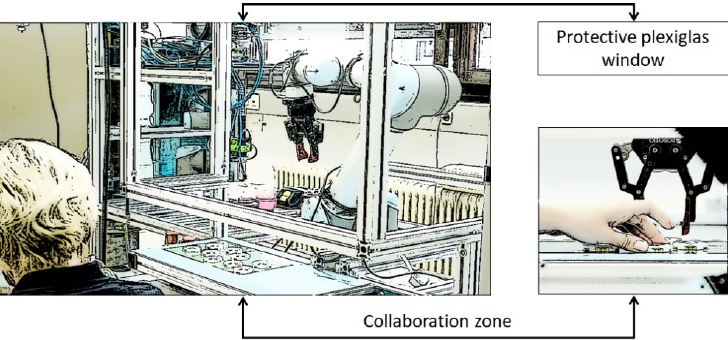
Figure 9. Plexibot scenario: human–robot collaboration (HRC) application from bayerdynamic ® [53].